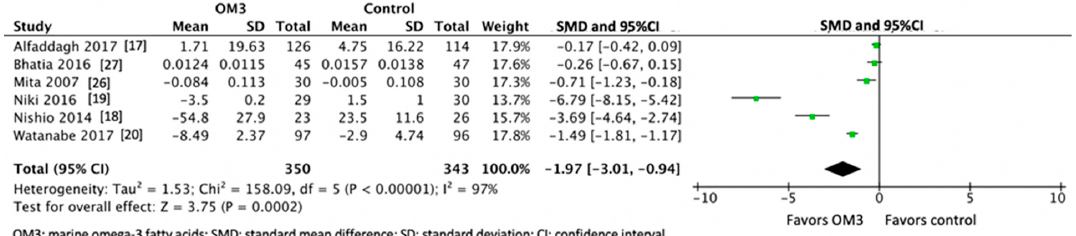
Figure 2. Effect of high-dose marine omega-3 fatty acids on atherosclerosis. Figure 2. E ff ect of high-dose marine omega-3 fatty acids on